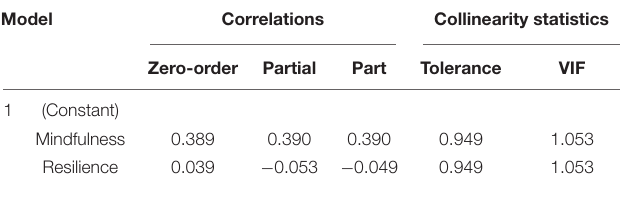
TABLE 2 | Correlations and collinearity.